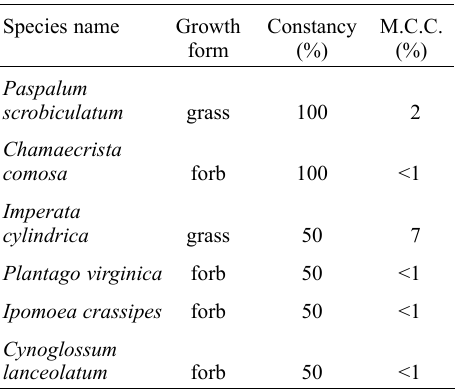
Table 8 Diagnostic species of the Paspalum scrobiculatum- Miscanthus junceus variant (M.C.C. - mean canopy